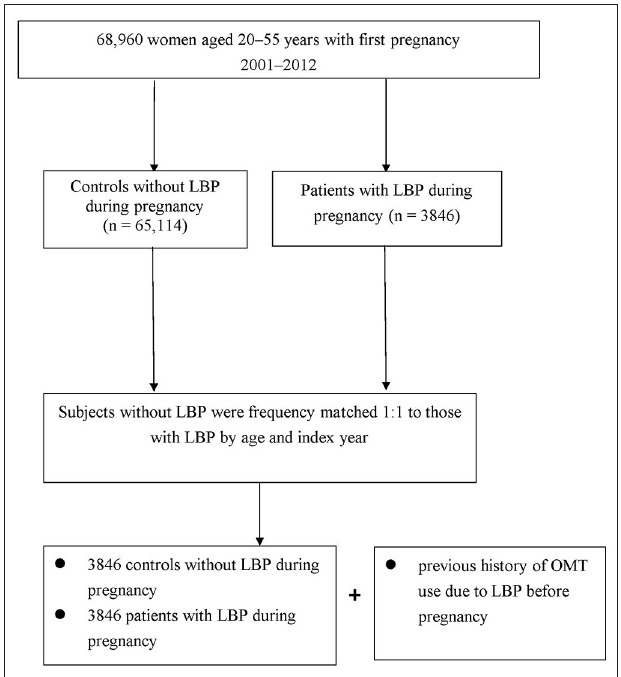
FIGURE 1 | Flowchart of patient screening.